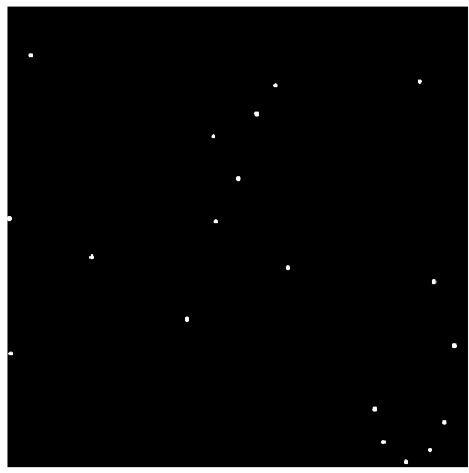
= 0.671). (cid:3017)(cid:3020)(cid:3007)